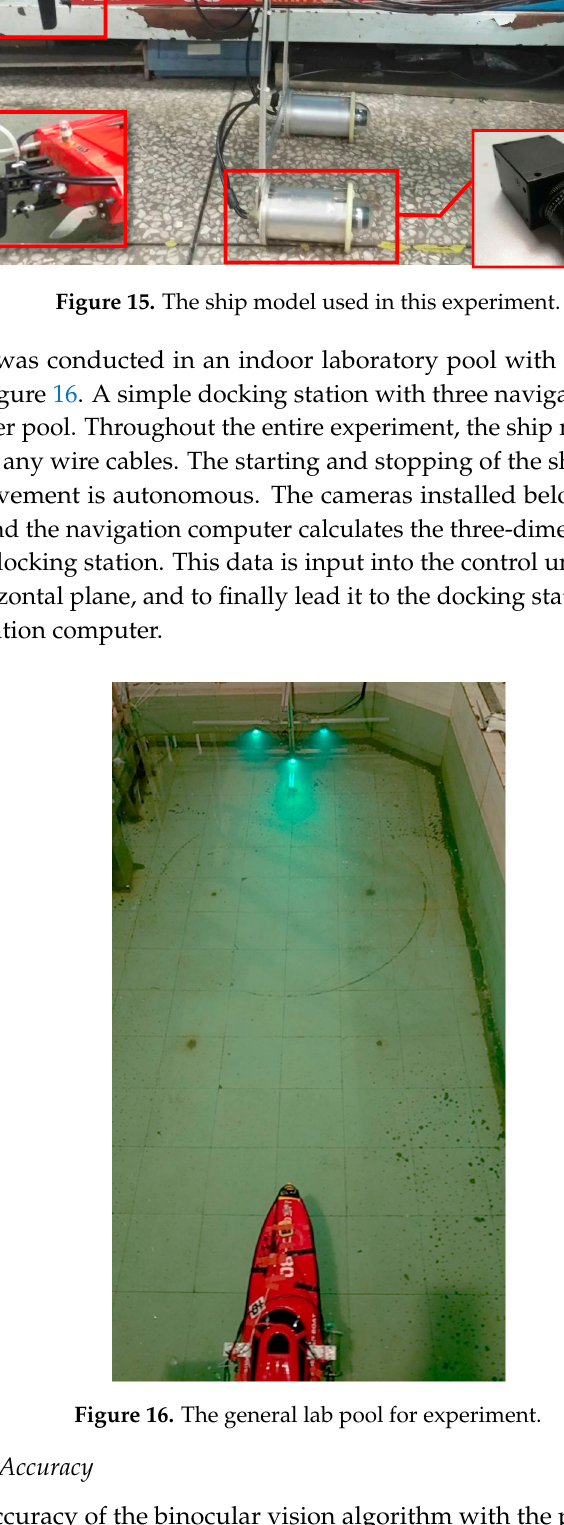
Figure 16. The general lab pool for experiment.